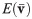
Reprinted from [Fig 6] under a CC BY license, with permission from [SUTC], original copyright [2018] total system emissions.Distribution of emissions in Shenzhen. Fig 6 (A) displays E(v¯) without tolls (g/h), and Fig 6 (B) displays E(v^) with differentiable tolls (g/h).